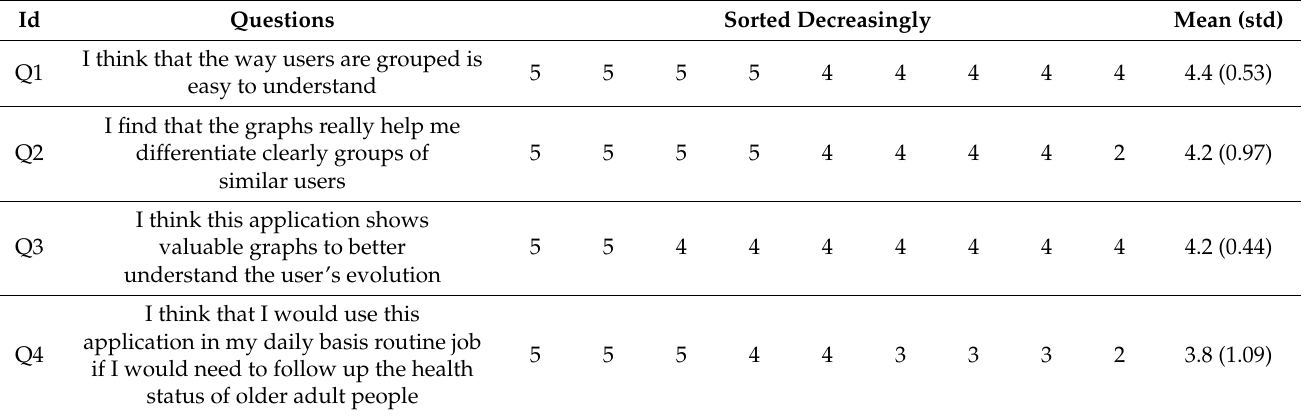
Table 5. Personalized questionnaire’s answers sorted in decreasing